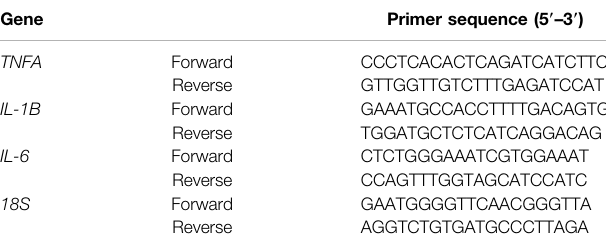
TABLE 1 | Primer sequence for quantitative real-time